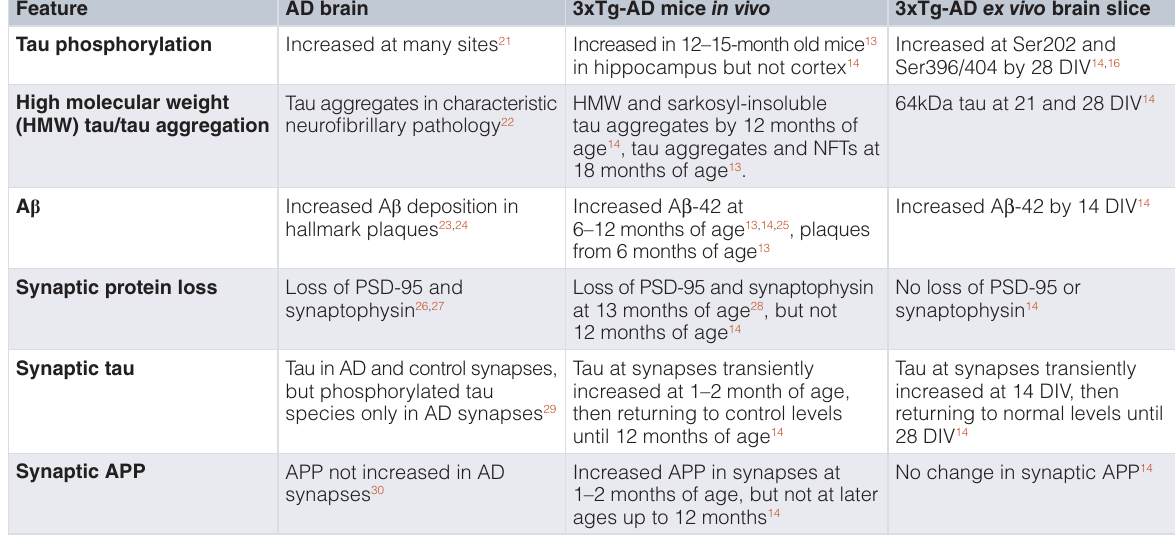
Table 1. Biochemical and pathological features of 3xTg-AD organotypic brain slices in comparison to in vivo 3xTg-AD brain and AD brain. Primary references are shown. AD: Alzheimer’s disease; DIV: days in